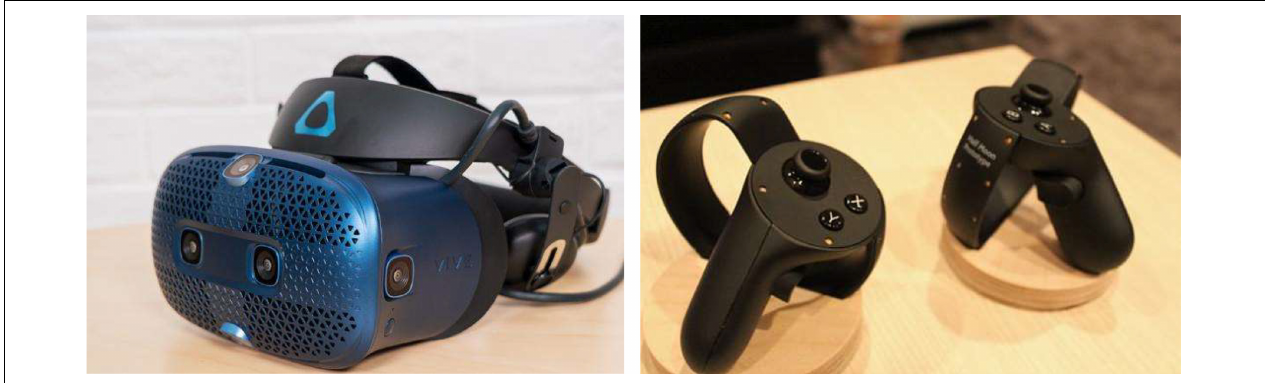
FIGURE 6 | HTC VIVE wearable device.